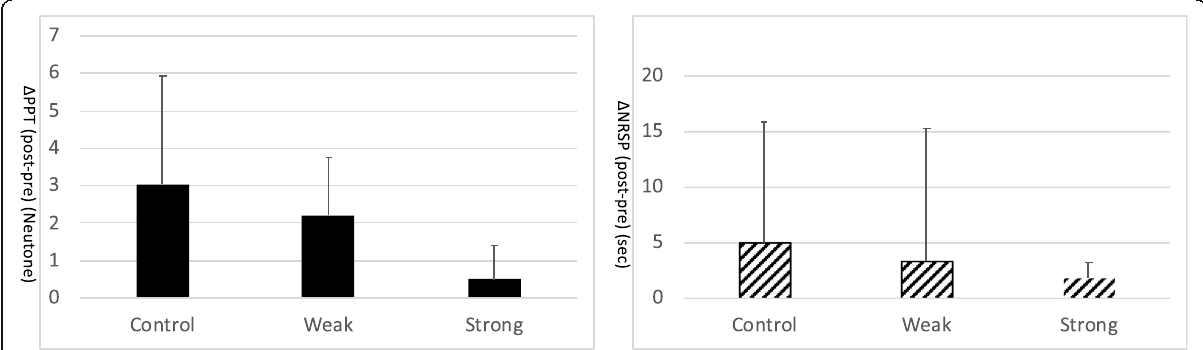
Fig. 1 PPT difference ( Δ PPT (post-pre)) (left) and NRSP difference ( Δ NRSP (post-pre)) (right) amongst the three patient group (mean ± SD) were not significant but showed tendency to decrease with pre-operative opioid (ANCOVA p > 0.15 for PPT, p > 0.9 for